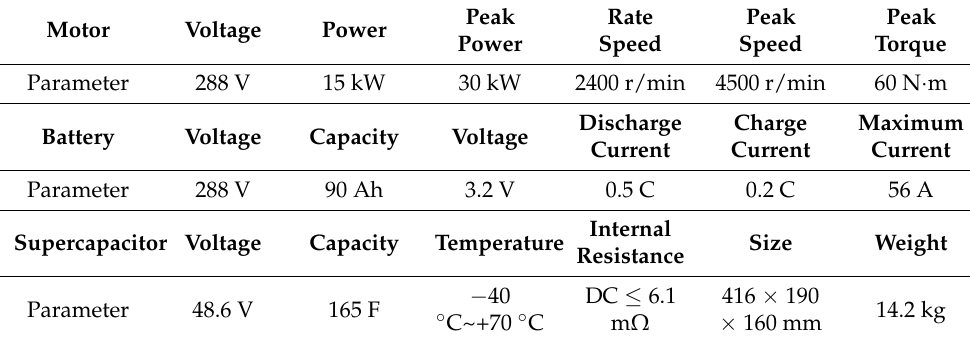
Figure 12. The experimental platform of an electric loader. Table 3. Detailed parameters of the experimental